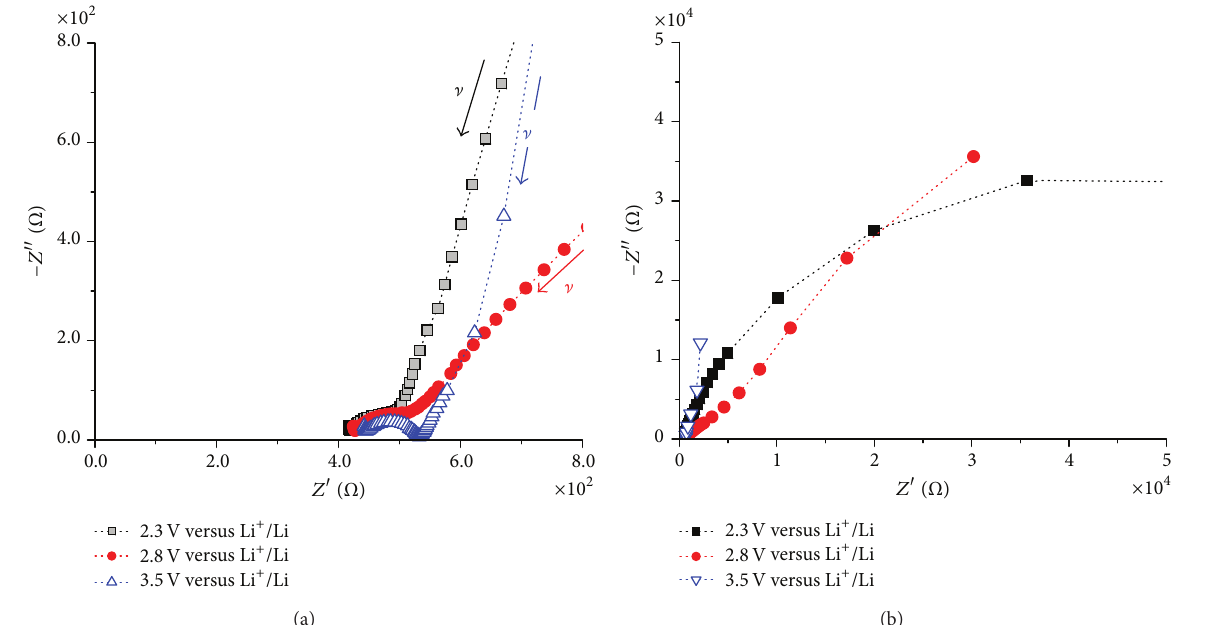
Figure 16: (a) High- and (b) low-frequency electrochemical impedance spectra of RDS NiO ( 𝑙 = 0.3 𝜇 m) spray-deposited onto ITO. x ). The selected values of 𝐸 are related to the nature of the NiO Impedance spectra were recorded at different applied potentials ( 𝐸 appl appl = 2.3 V versus Li + /Li), in the partially oxidized state ( 𝐸 layer, in the pristine uncharged state ( 𝐸 = 2.8 V versus Li + /Li), and in the fully appl appl = 3.5 V versus Li + /Li). For electrolyte and cell configuration used, see Figure 1. In the upper plot the arrows indicate the oxidized state ( 𝐸 appl direction of increase for the frequency of polarization.